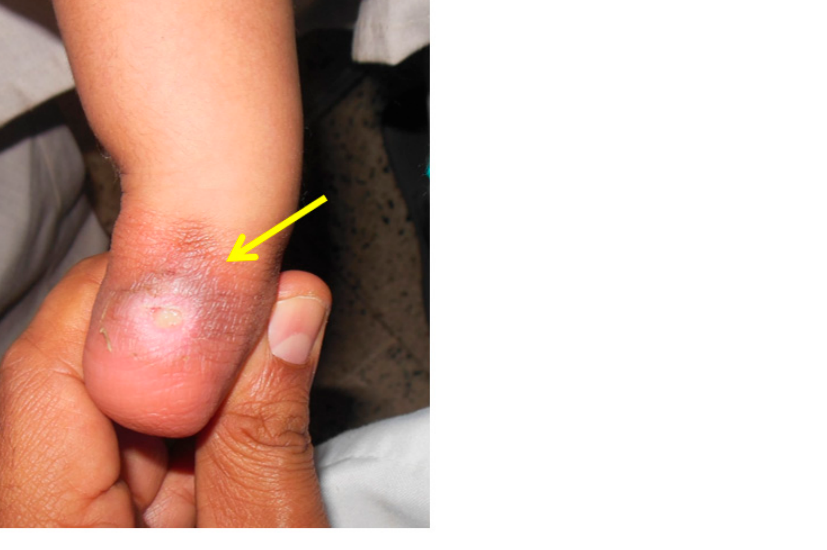
Figure 11. Friction sore on the posterior aspect of the heel (pointed by the arrow) due to the brace being too loose (inadequately tightened).